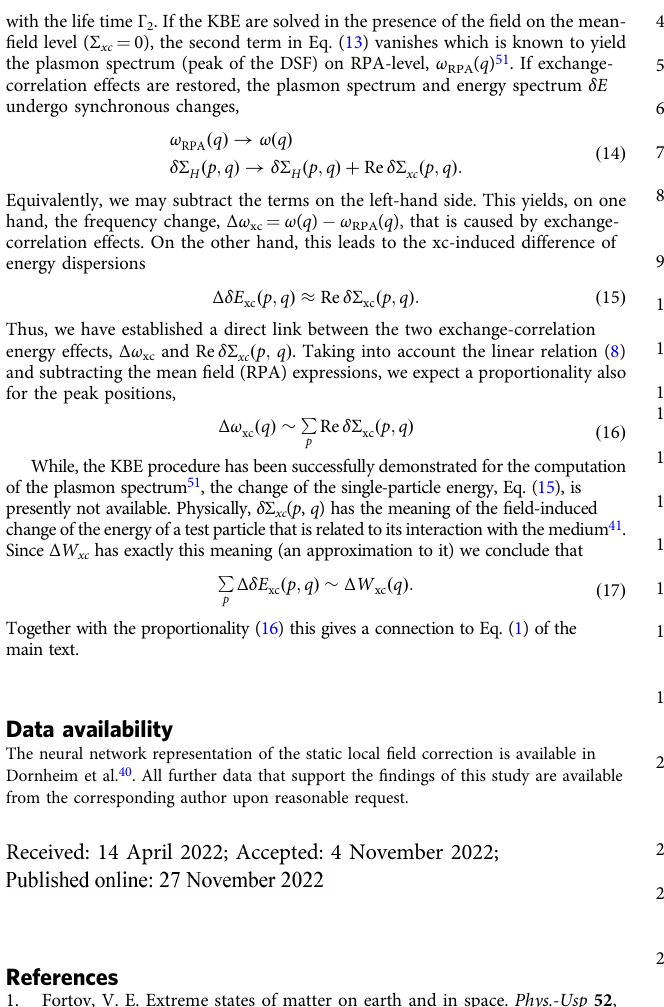
Fig. 6 Wavenumber dependence of the spectrum of density fl uctuations ω ( q ) at different conditions. Dotted green: random phase approximation (RPA); dashed black: static approximation; solid blue: exact path integral Monte Carlo (PIMC) results 20 ; solid red: electronic pair alignment model [Eq. (1)] introduced in this work. a Results for different values of the density parameter r s at θ = 1; b results for different values of the temperature parameter T / E r = θ = k s B F for